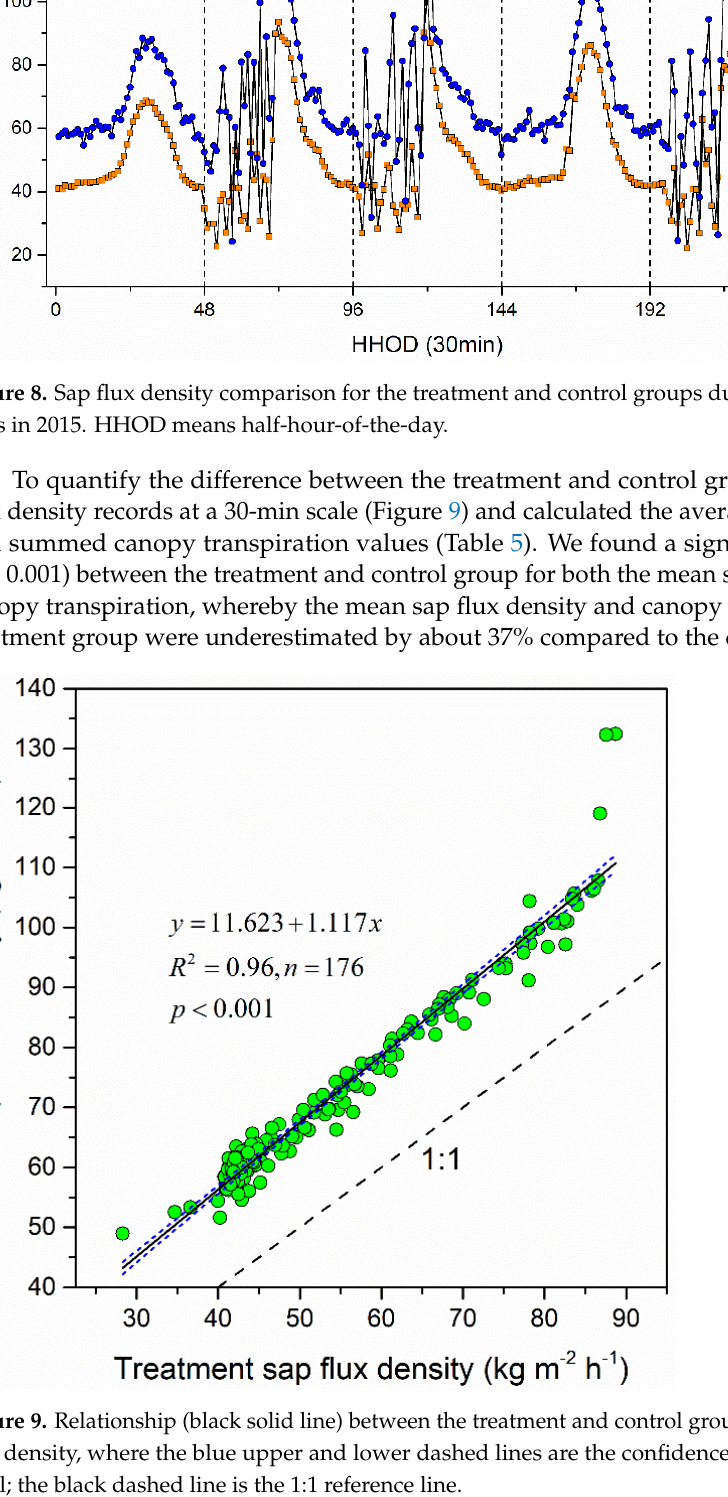
Figure 7. Relationships between sap flux density and VPD, global short-wave radiation, average air temperature, and daily TWD for the control group over the growing season.